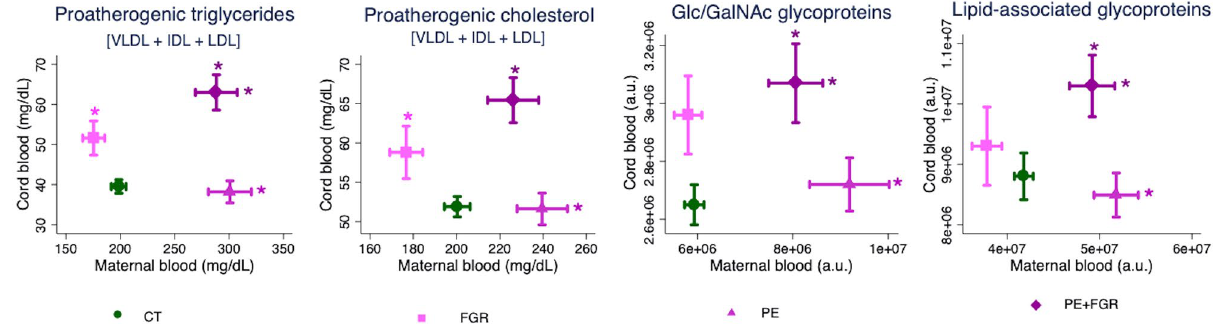
Figure 3. Lipid profiles across the different groups. Proatherogenic triglycerides and cholesterol, and Glc/ GalNAc and lipid-associated glycoproteins in plasma samples from maternal blood (X-axis: controls [n = 88], FGR [n = 44], PE [n = 40], PE + FGR [n = 50]) and cord blood (Y-axis: controls [n = 86], FGR [n = 43], PE [n = 37], PE + FGR [n = 50]). The plots show the mean values in each group + /− SEM. * p < 0.05 according to Student’s t -test or Mann Whitney U test and confirmed by linear regression (adjusted for maternal body mass index, smoking, sample collection date, gestational age at delivery/sampling, route of delivery and fetal gender) and 5% false discovery rate correction compared to controls (Supplementary Table S1). CT, controls; FGR, fetal growth restriction; Glc/GalNAc, N-acetylglucosamine and N-acetylgalactosamine bonds; PE, (Fig. 2). Additional observations included a more heterogenous distribution of proatherogeneic triglycerides compared to controls in FGR fetuses with or without PE, and in PE mothers with or without FGR (2–2.5 fold larger IQR of VLDL), similar to Glc/GalNAc glycoproteins in the latter groups (Supplementary Table S1).